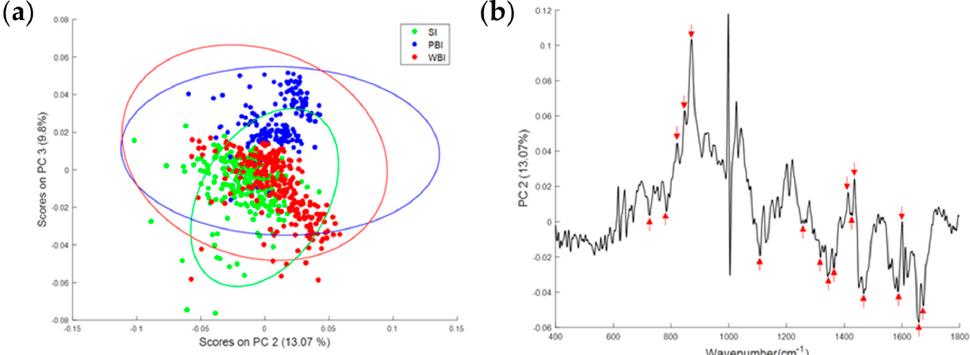
Figure 5. ( a ) PCA scatterplot of Raman spectral data from SI (green), PBI (blue) and WBI (red) mice 15 days post-irradiation. ( b ) PC loading from PCA of Raman spectral data from SI, PBI and WBI mice 15 days post-irradiation showing spectral features responsible for the separation between the groups (red arrows).